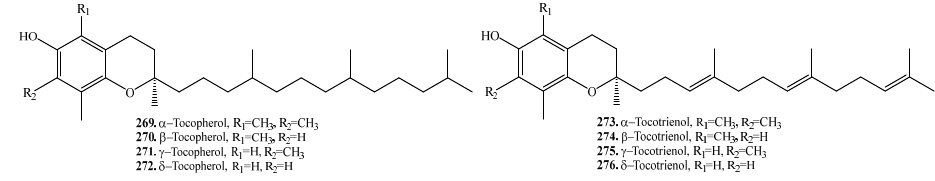
Figure 9. Structures of the other compounds isolated from rice.